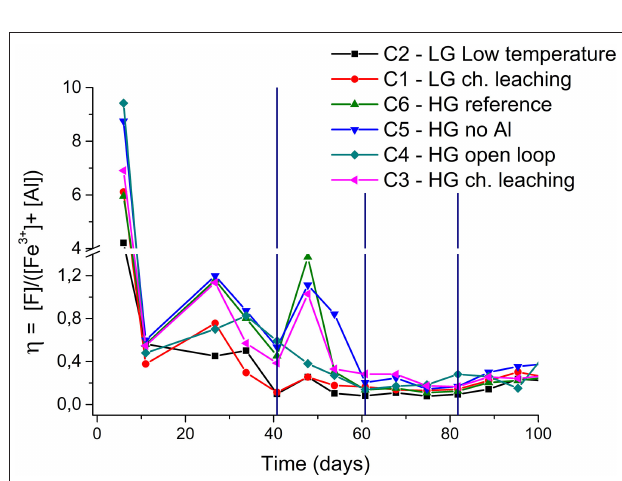
FIGURE 6 | Profile of the η parameter with time during the bioleaching of inoculated columns. The vertical lines indicate solution bleeding. Experiments with S. thermosulfidooxidans growing in Norris growth medium supplemented with yeast extract (0.1 g/L) and amended with 1.0 g/L Al 3 + (unless otherwise stated); at 50 ± 1 ◦ C (columns C1, C3–C6) or room temperature (column C2); crushed and agglomerated ore (½ ′′ top size); 8.6 L/m 2 /h solution flow-rate and 2.16 m 3 air/m 2 /h air